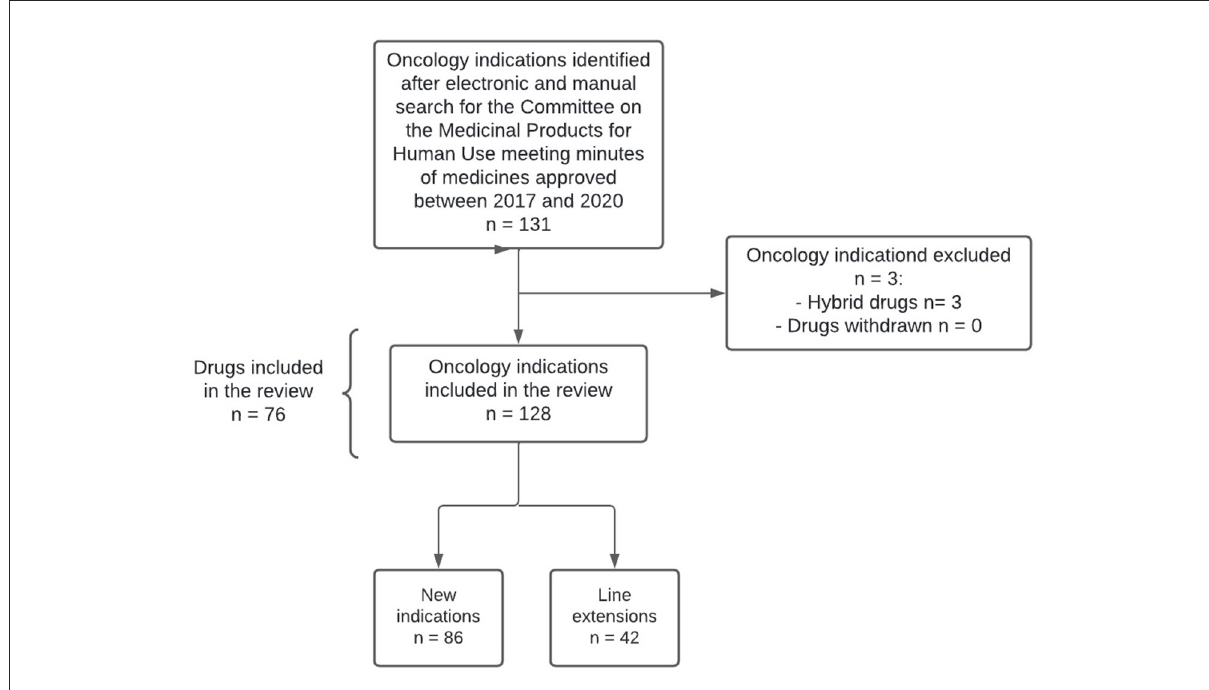
FIGURE1 Research methodology